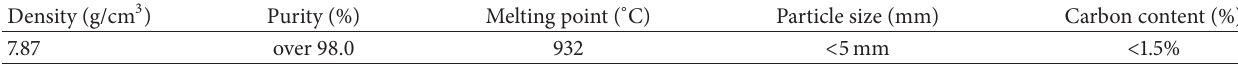
Table 4: Physical properties of SP.